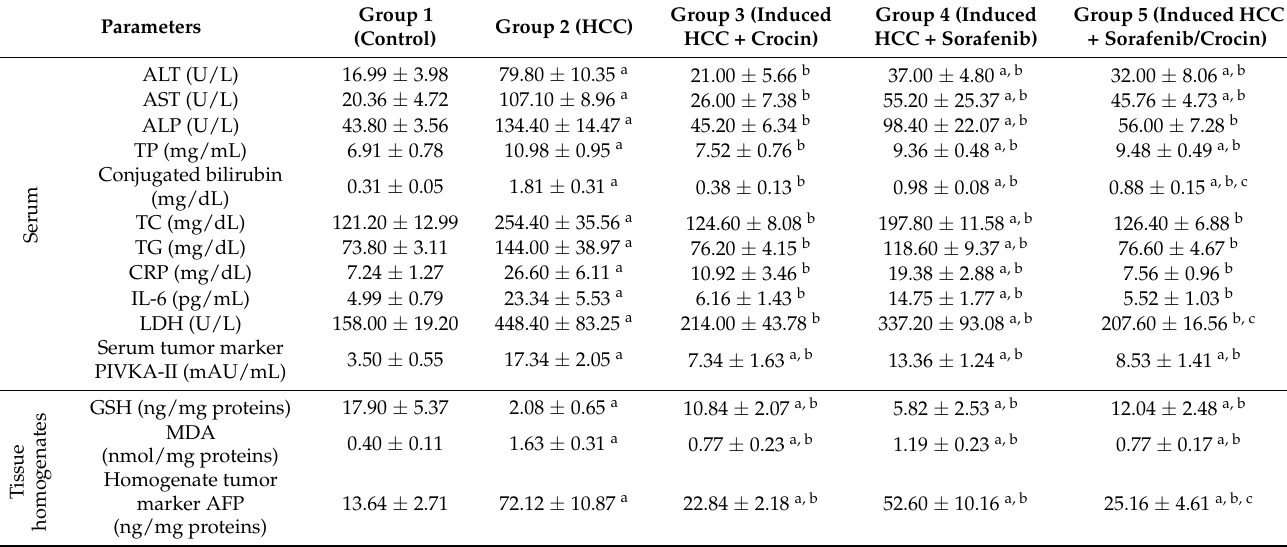
Table 3. Measured parameters in different studied